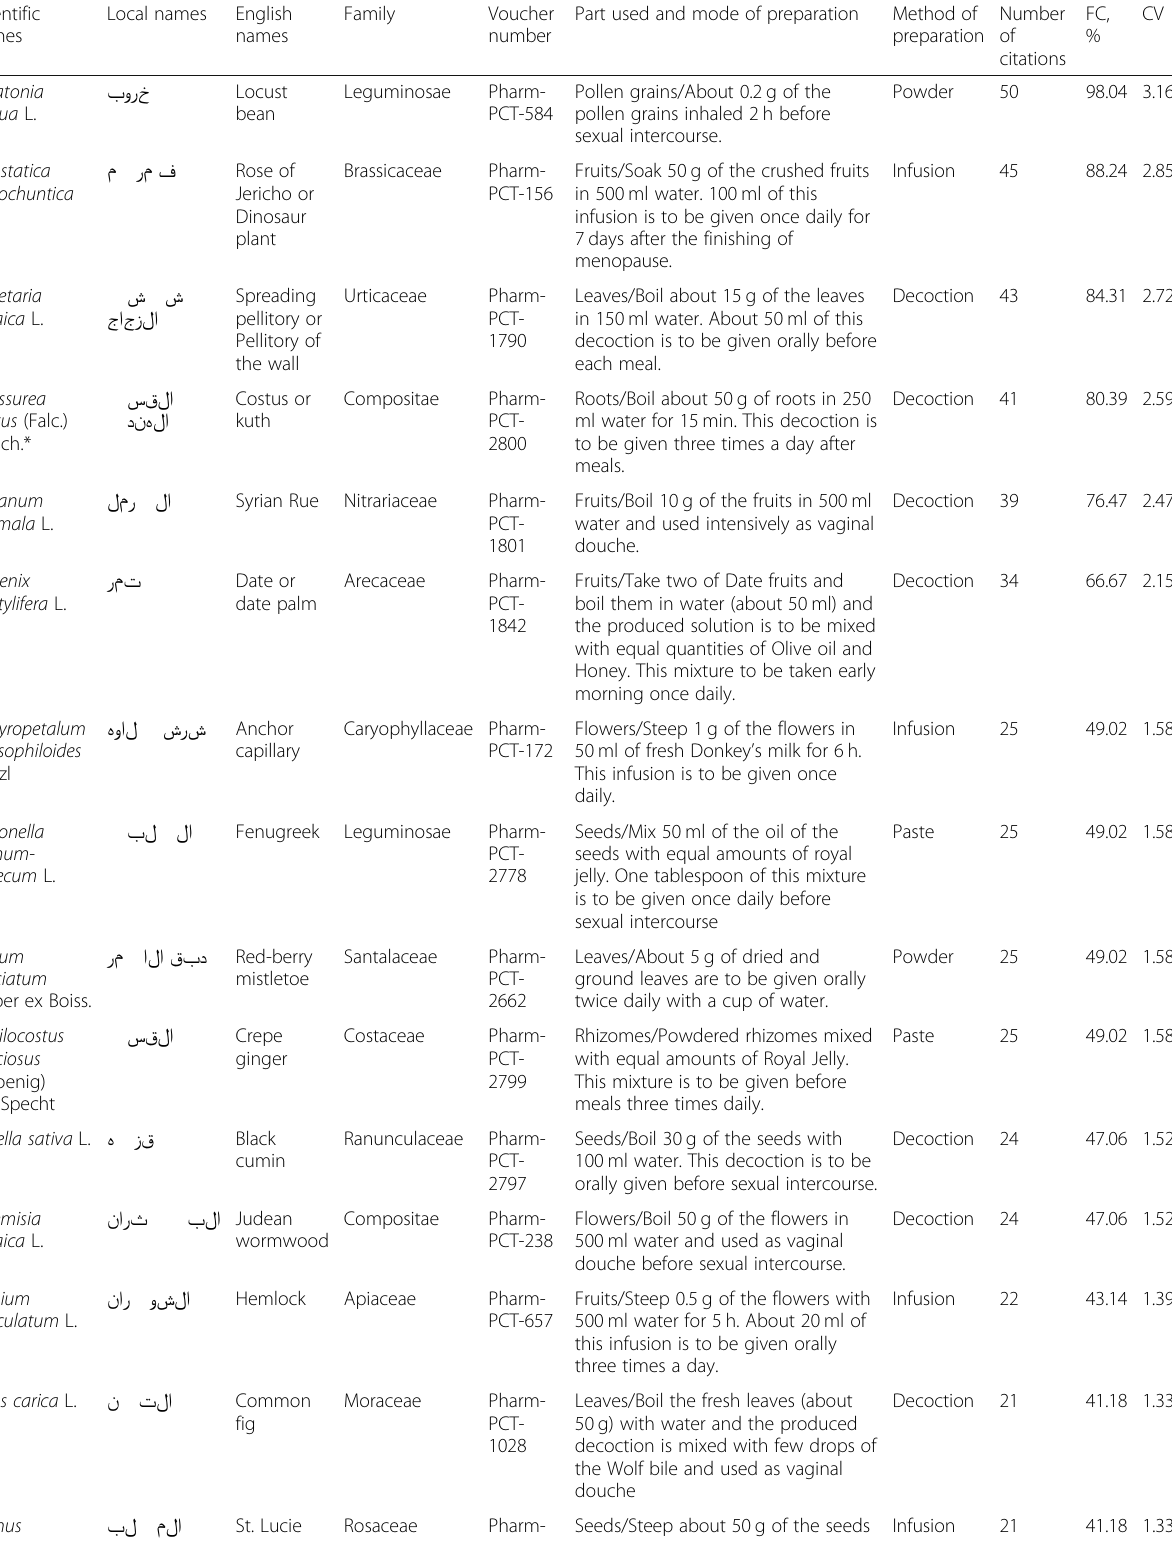
Table 2 The used herbals for the treatment of infertility in females, the plant ’ s parts used, Frequency of Citation (FC), Choice values, modes of administration and methods of